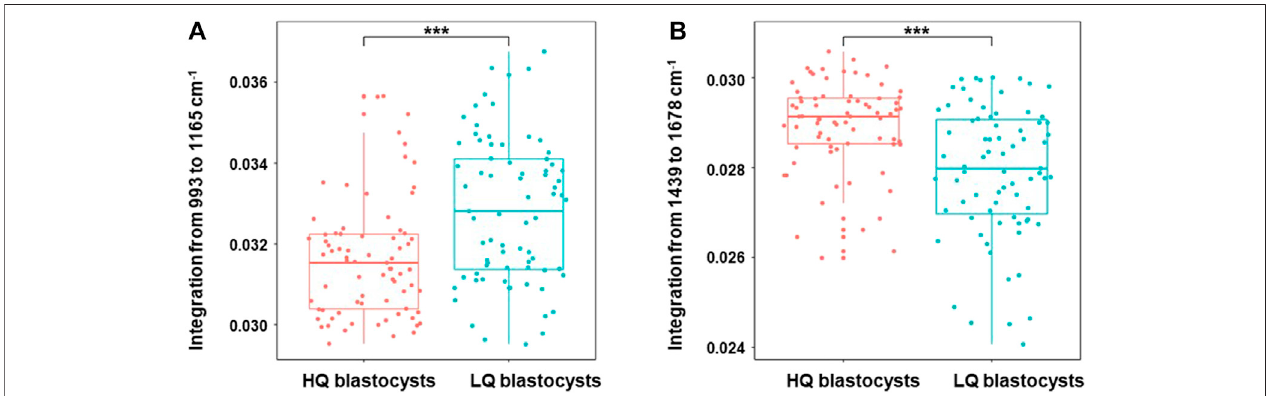
FIGURE 5 | Boxplots of Raman band integration of high-quality blastocysts group and low-quality blastocysts group in PCOS. The signi fi cant differences at 993 – 1,165 cm − 1 (A) and 1,439 – 1,678 cm − 1 (B) were shown between high-quality blastocysts and low-quality blastocysts groups in PCOS. The rectangle in the box plotsrepresentsthesecondandthethirdquartiles,withthelineinsiderepresentingthemedian.Thelowerandupperquartilesaredrawnaslinesoutsidethebox.Sample means were compared by Welch 2-sample t test for unequal variances. *** indicates p < 0.001.